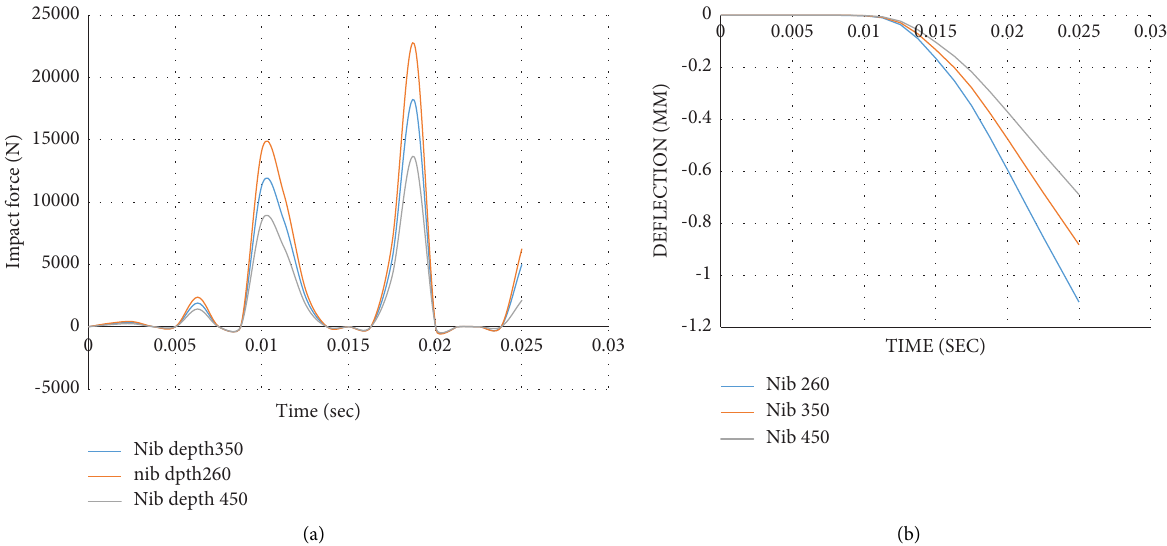
Figure 11: (a): Impact force vs time for nib depth 260, 350, and 450. (b): Defection vs. time graph for nib depth 260, 350, and